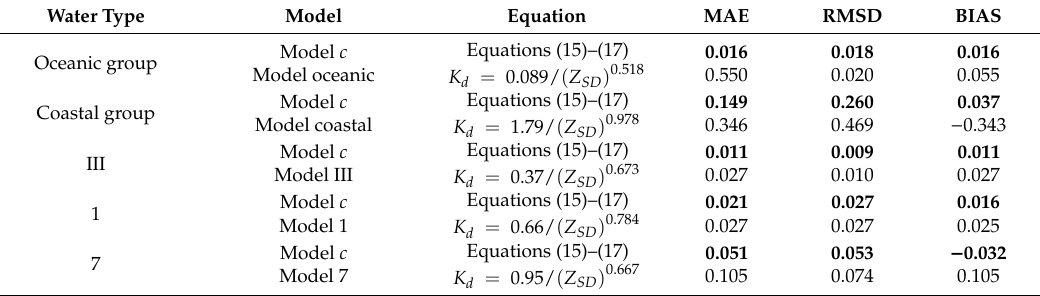
Table 4. Evaluation of the K din situ versus a specific model by water type and model c . The bold show the best